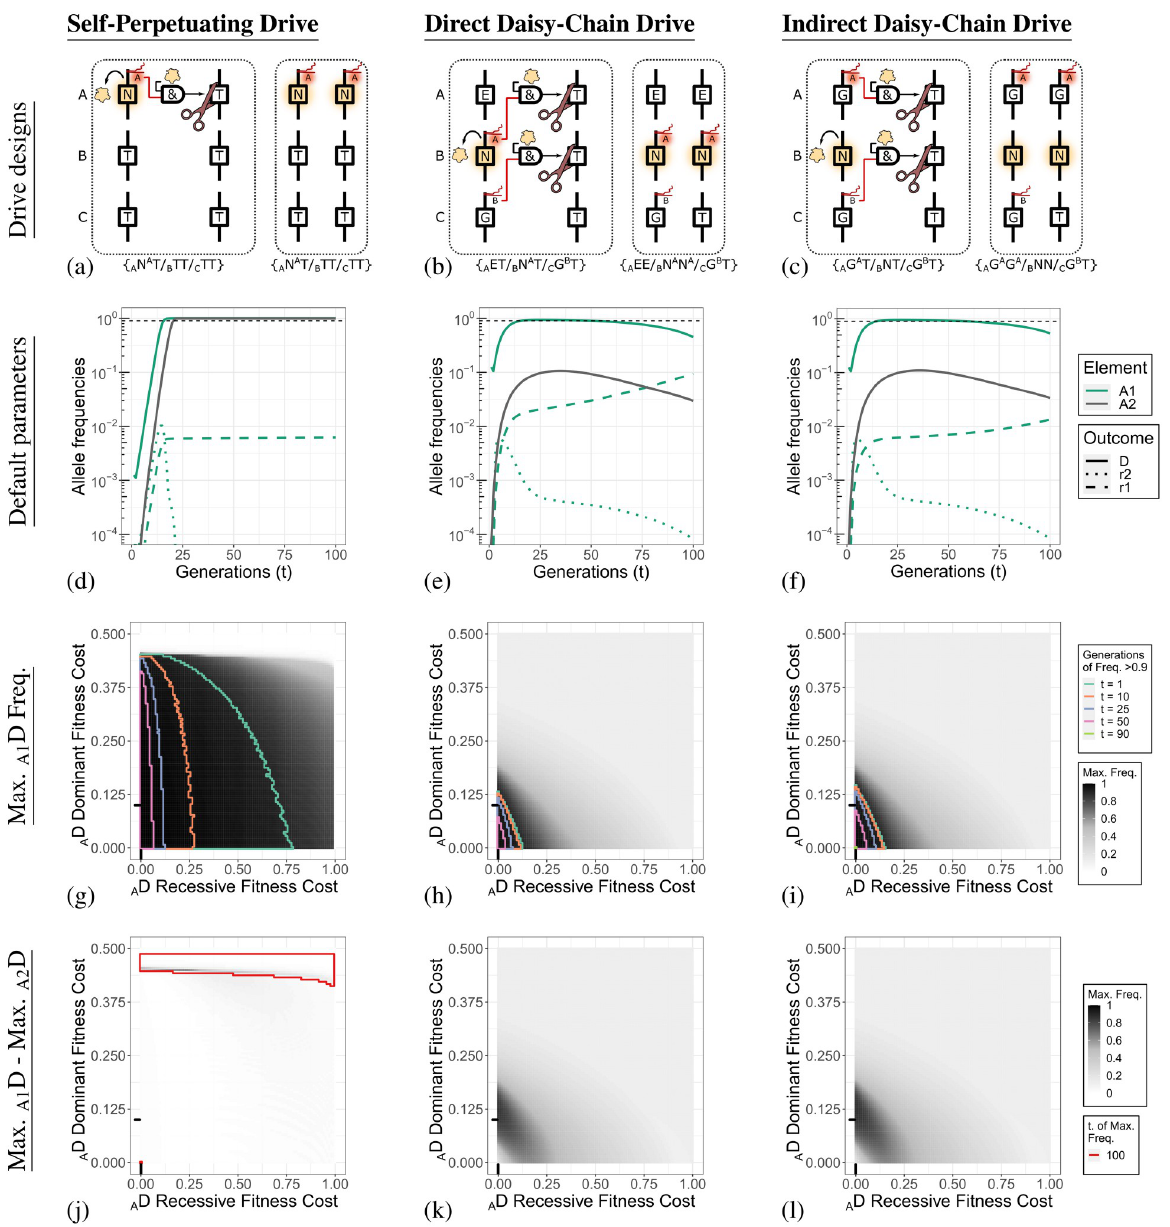
Fig 2. Illustration of drive designs, default behaviour, and performance when subjected to different recessive and dominant A D fitness costs. Column 1 . Self-Perpetuating Drive. Column 2 . Direct Daisy-Chain Drive. Column 3 . Indirect Daisy-Chain Drive. Row 1 (a-c) . Illustration of the molecular designs of the three drives we simulate. Each design is shown as heterozygote, with on the right the product resulting from inheritance bias. Row 2 (d-f) . A locus allele dynamics under the default conditions. The thin dashed line indicates a frequency of 90%. An allele at locus A in population one is indicated by A1 (green lines), and a drive allele at locus A in population two is indicated by A2 (gray line). Type 1 and 2 resistance alleles are not shown for population two in these panels. The allele dynamics for all loci are shown in S2 Fig. Row 3 (g-i) . Parameter sweep for different recessive and dominant fitness costs applied to the A D ( A N A / A E/ A G A ) allele. The shading of the heat map indicates the maximum A D allele frequency in population one reached within the 100 generations simulated. The maximum frequency of A 1 alleles and outcomes for population two are shown in S7 Fig. An immediate decline after release results in the maximum frequency being the release frequency. Regions are boxed with coloured lines that indicate threshold values for the number of generations in which the A1 D allele frequency was greater than 90%. The black lines on each axis indicate the default value for the parameter being varied. Row 4 (j-l) . Difference in the maximum A D allele frequency between population one and two. Regions boxed with a red line are simulations in which the maximum allele frequency of population one or two was at generation 100 and the outcomes may change if additional generations are